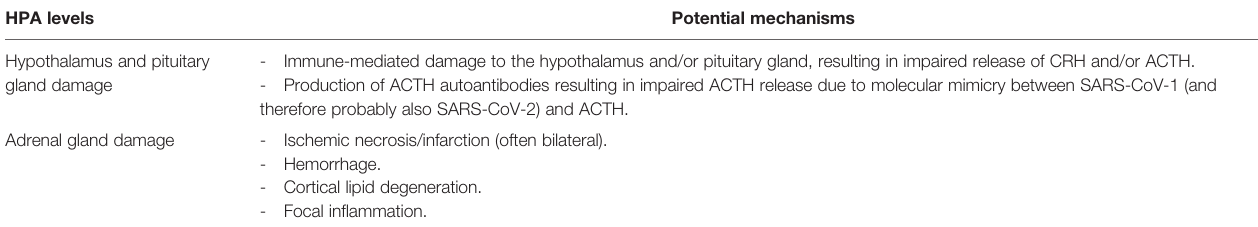
TABLE 1 | Potential mechanisms involved in de novo development of adrenal insuf fi ciency due to SARS-CoV-2. HPA